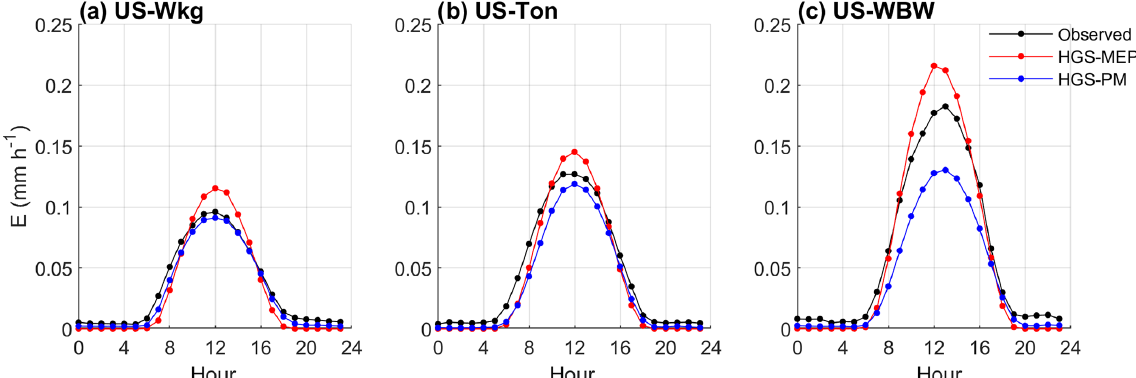
Figure 5. Observed and modelled hourly average terrestrial evaporation at (a) US-Wkg (climate: semi-arid; vegetation: grassland), (b) US- Ton (climate: Mediterranean; vegetation: woody savanna) and (c) US-WBW (climate: temperate; vegetation: deciduous broadleaf